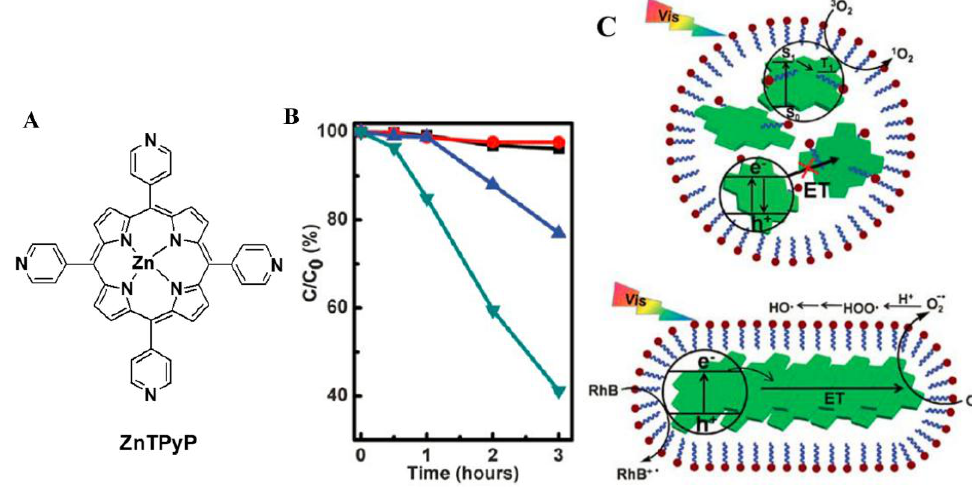
Figure 1. ( A ) Molecular structure of zinc-tetra (4-pyridyl) porphyrin (ZnTPyP); ( B ) photocatalytic activities of ZnTPyP-based nanospheres ( ● ), nanospheres/nanofibers ( ▲ ), nanofibers ( ▼ ) and no catalyst ( ■ ) for rhodamine B (RhB) photodegradation under visible-light irradiation; ( C ) a schematic illustration on the structure of ZnTPyP nanospheres and nanofibers and their morphology-dependent